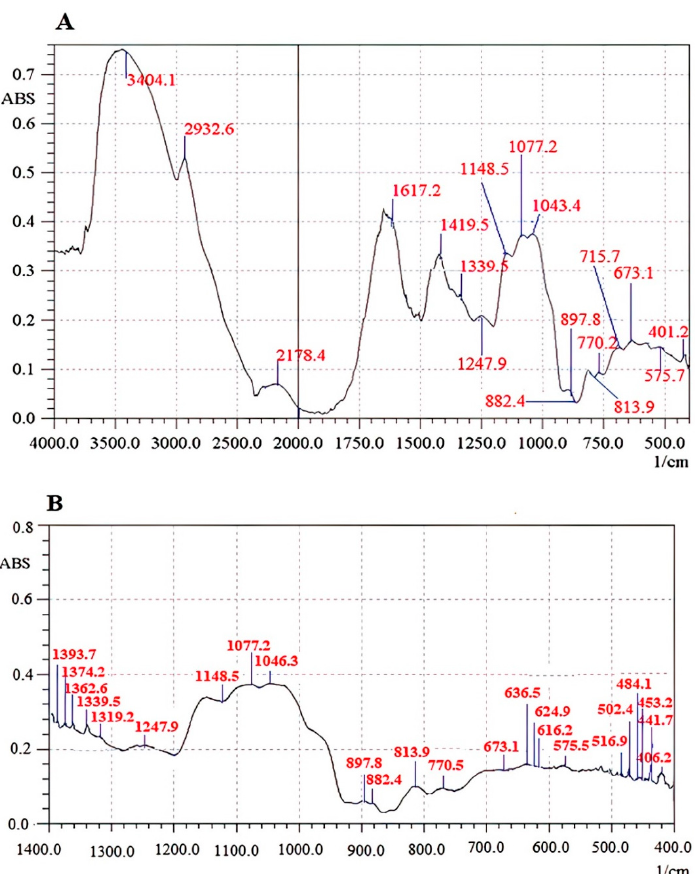
Figure 1. The FT-IR spectrum of the Se-exopolysaccharide fraction Le-P-Se. ( A ) In the scope of 4000.0 to 500.0 1/cm. ( B ) In the scope of 1200.0 to 400.0 1/cm.